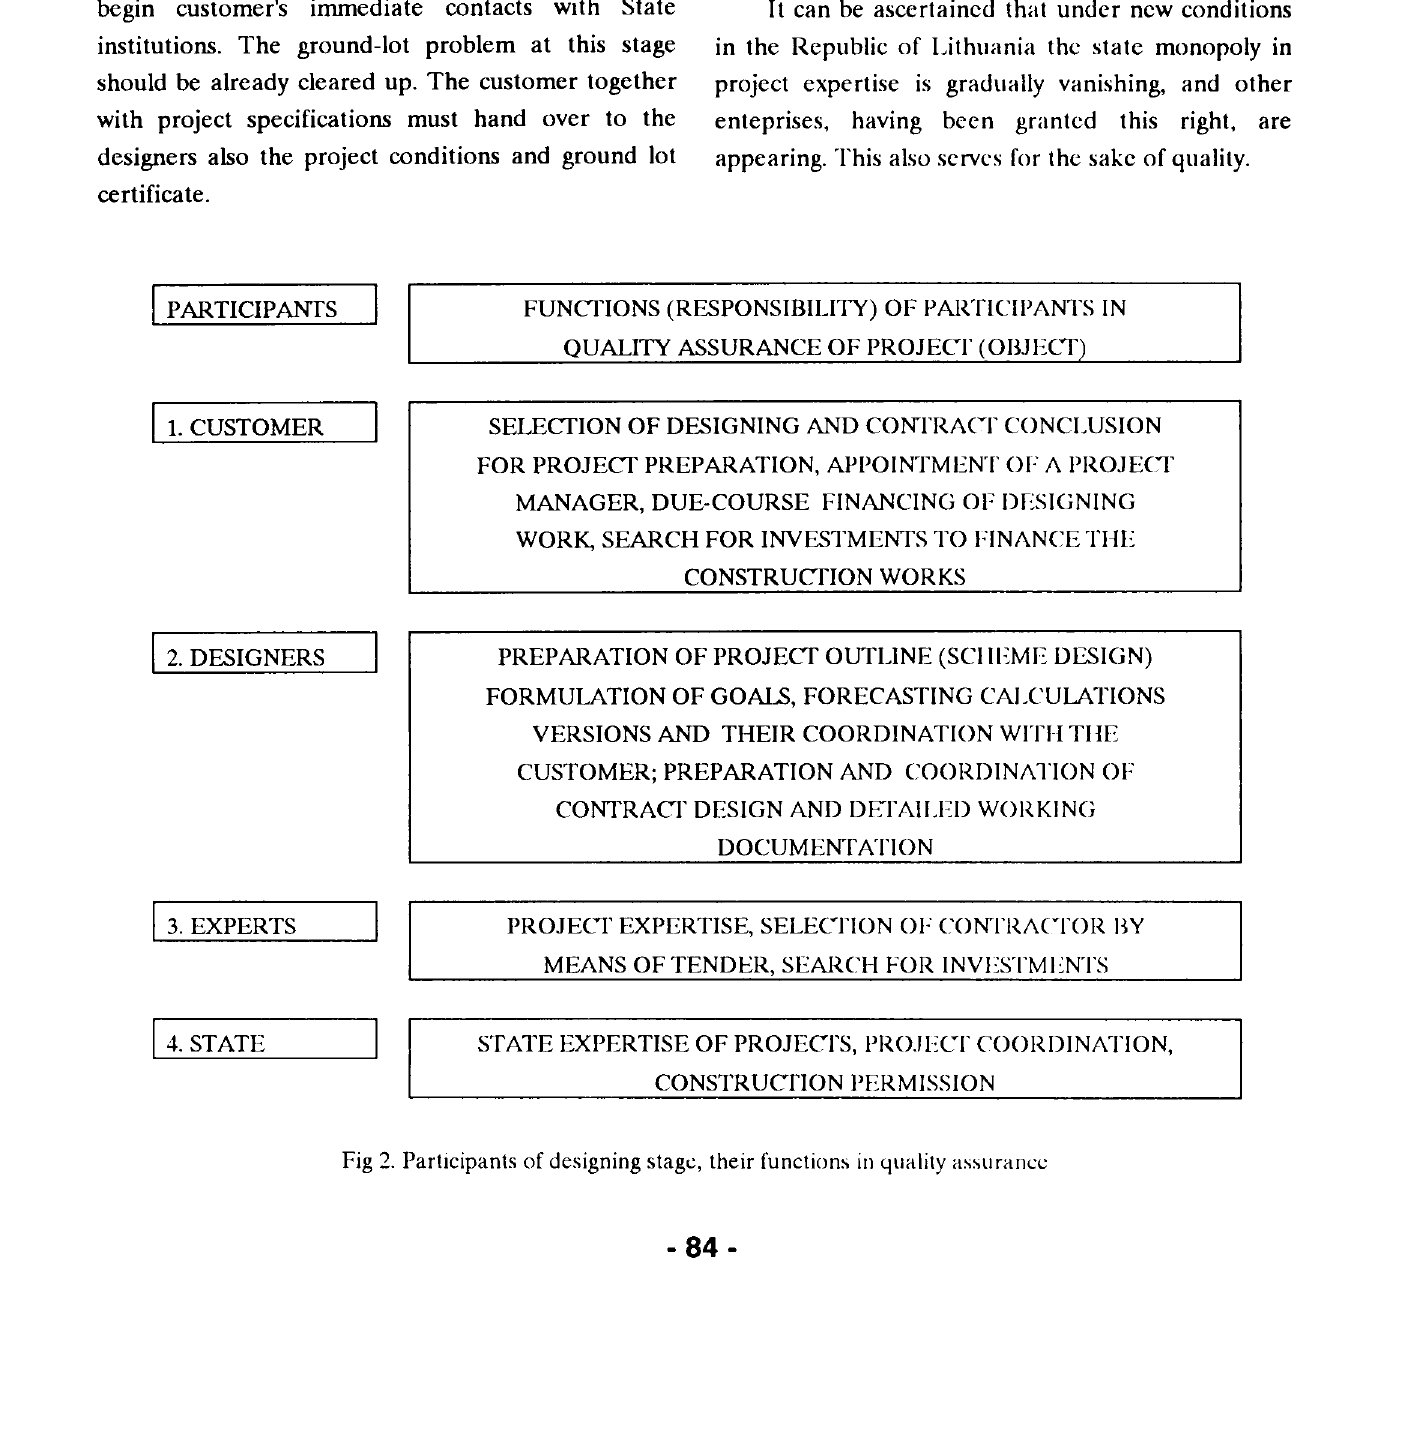
Fig 2. Participants of designing stagt.:, their functions in quality